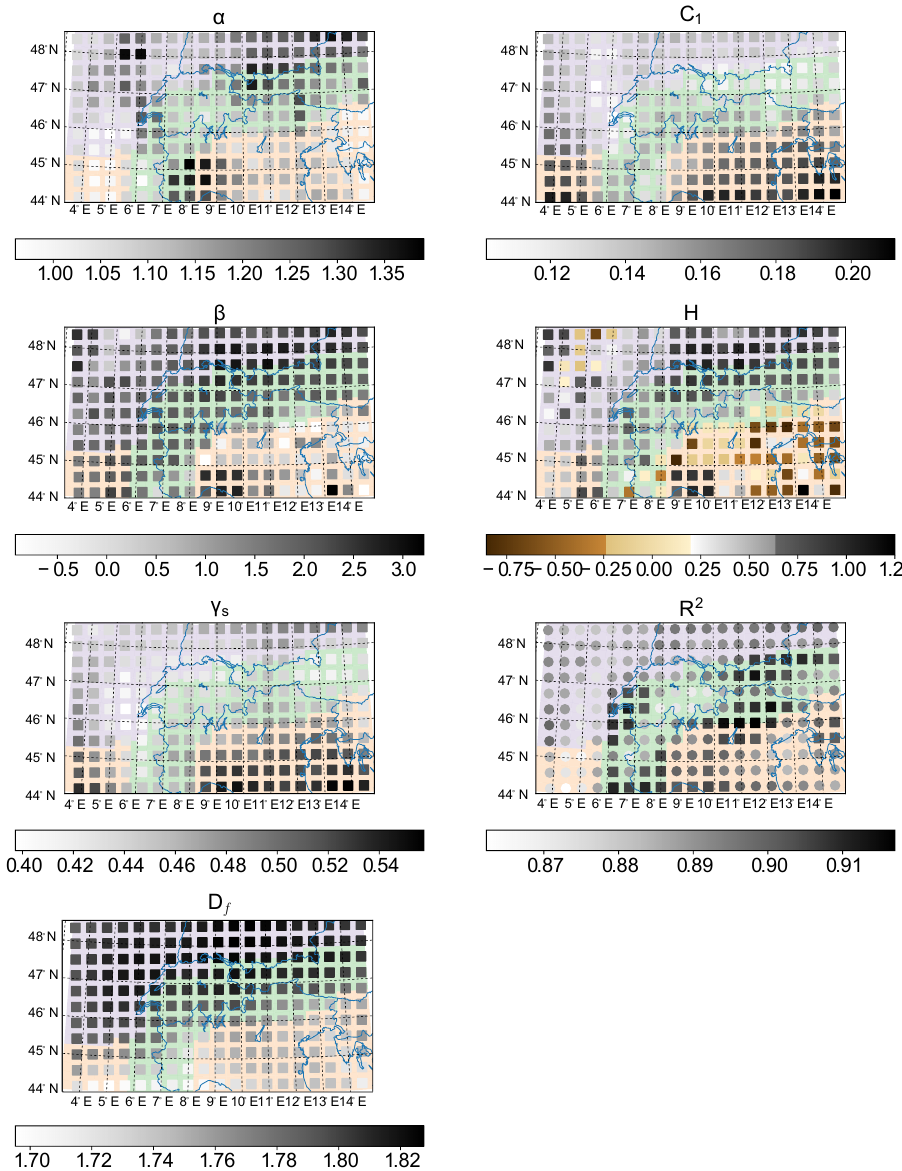
Figure 6. Spatial representation of the MF parameters estimated in space for all areas. The special colormap for H has been chosen to separate positive and negative values and highlight non-conservative areas where | H | > 0 . 5. For R 2 , circles represent all zones where R 2 < 0 . 9, whereas squares represent all zones with good scaling ( R 2 ≥ 0 . 9). As previously mentioned, the size of the represented squares is not to scale. The colors in the background correspond to the hierarchical